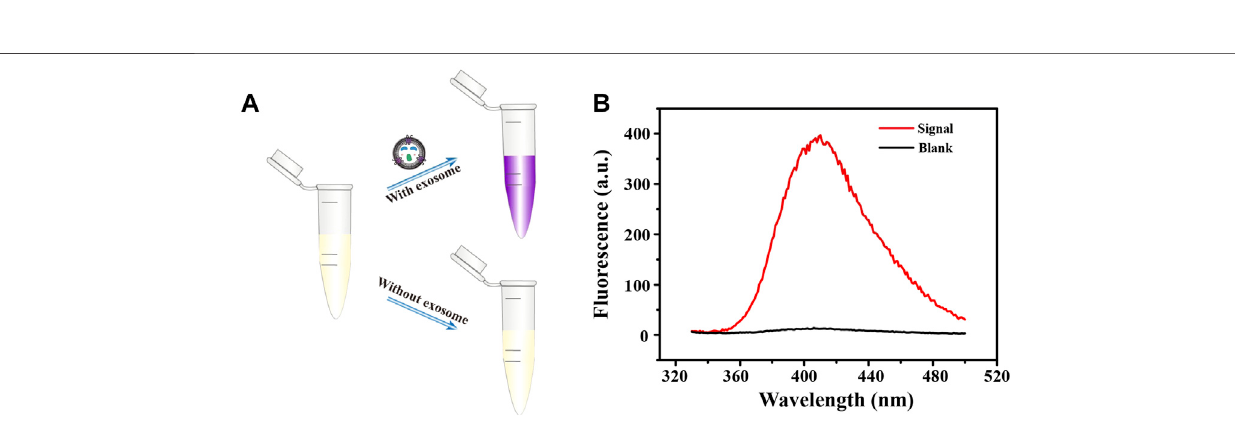
Frontiers in Bioengineering and Biotechnology |